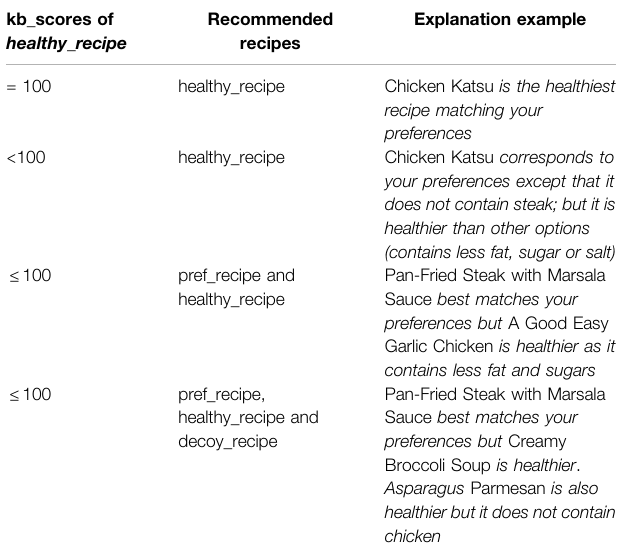
TABLE 6 | Subjective questionnaire adapted from (Pu et al., 2011) to measure users ’ perceived quality of the